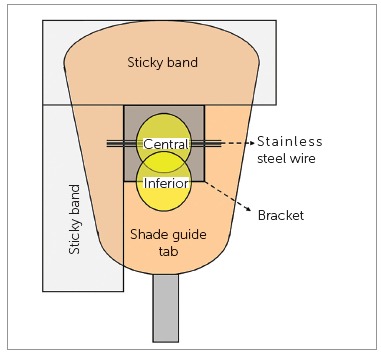
Experimental set up.
22